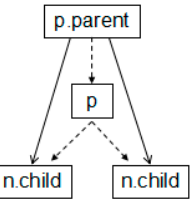
Figure 9. The change of edges when a point expires.